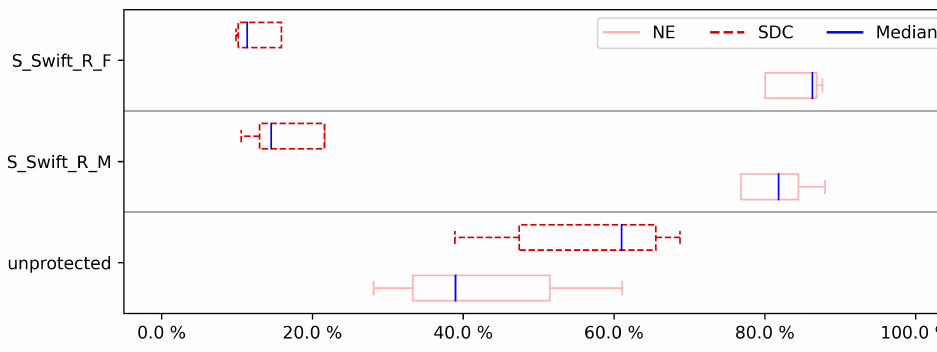
Figure 7. CFE fault injection results for 3 registers.